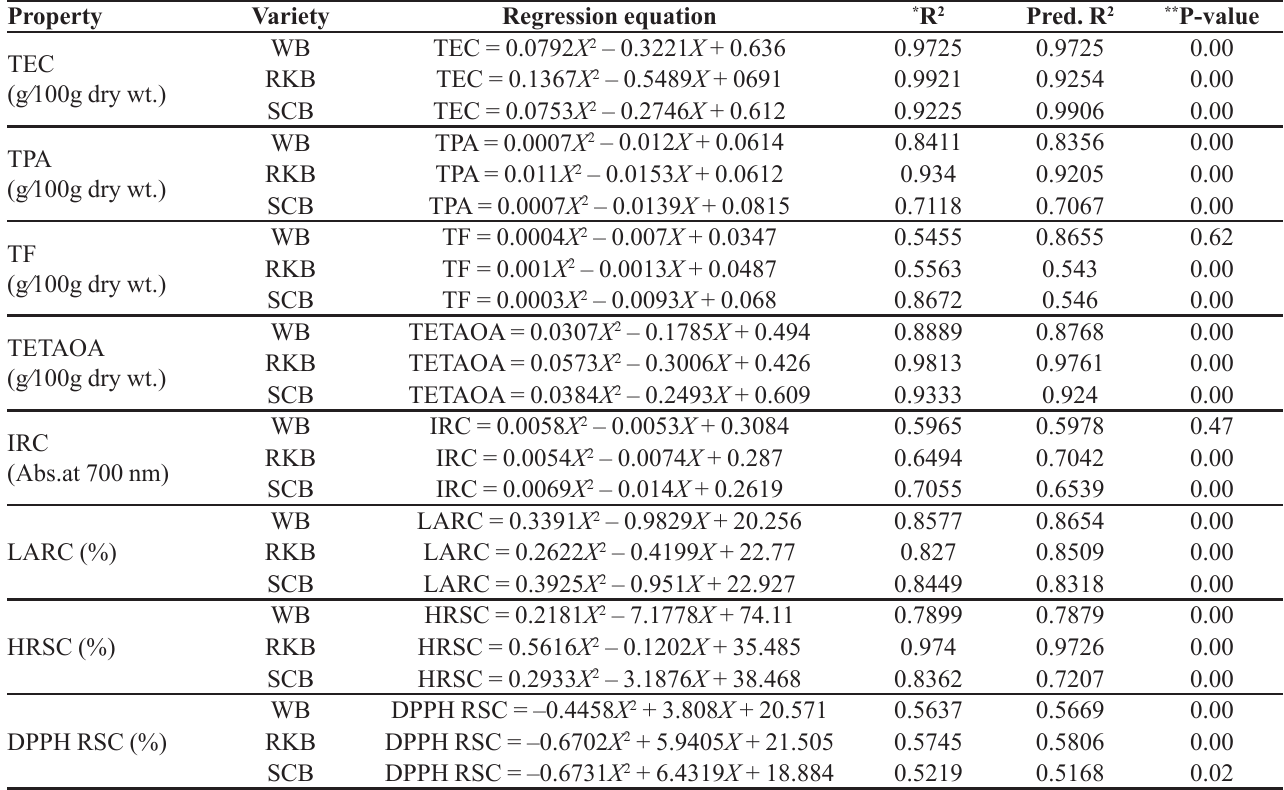
beans, SCB: small common